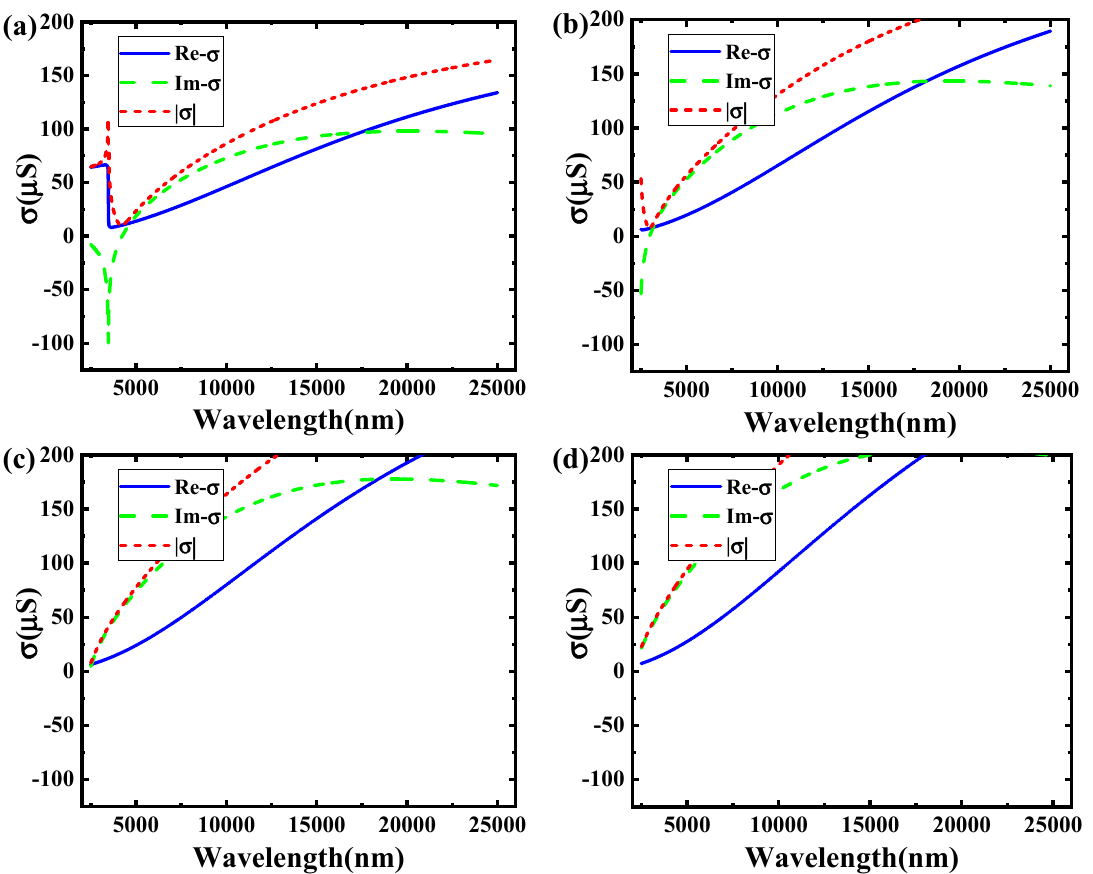
Figure 4. The image of conductivity as a function of incident wavelength in different voltage. ( a ) 0.5 V; ( b ) 1 V; ( c ) 1.5 V; ( d ) 2 V.